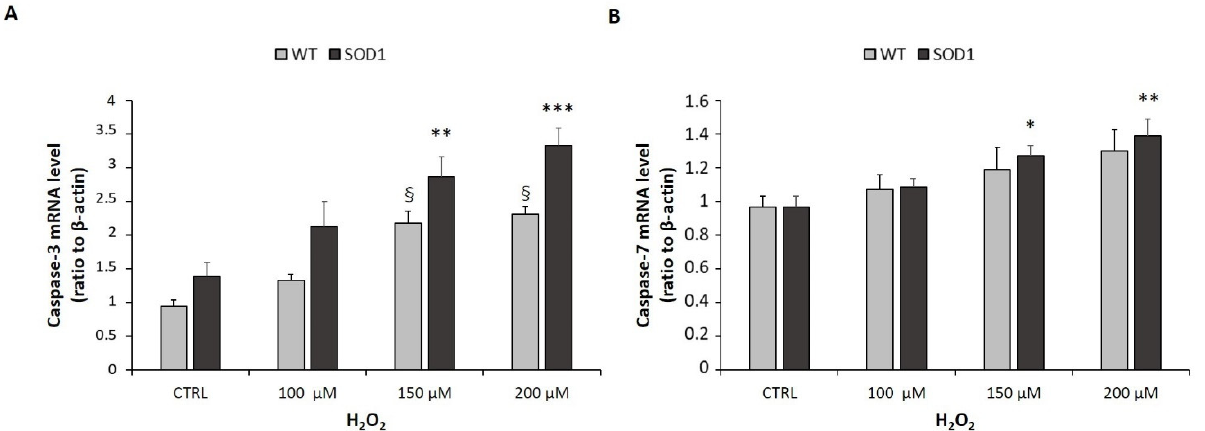
Figure 7. Caspase-3 and caspase-7 mRNA levels following incubation with increasing concentrations of H 2 O 2 . SH-SY5Y WT and SOD1 G93A cells were incubated with different concentrations of H 2 O 2 alone (0, 100, 150, 200 µM). Caspase-3 ( A ) and caspase-7 ( B ) mRNA levels were measured by RT-PCR and normalized for the respective β -actin mRNA levels. Data are expressed as mean ± SEM of 18 replicates obtained in 3 independent experiments (n = 6 in each 18 replicates obtained in 3 independent experiments ( n = 6 in each experiment). For SH-SY5Y WT: experiment). For SH-SY5Y WT: § p < 0.05 vs. CTRL; for SH-SY5Y SOD1 G93A * p < 0.05, ** p < 0.01, and § p < 0.05 vs. CTRL; for SH-SY5Y SOD1 G93A * p < 0.05, ** p < 0.01, and *** p < 0.001 vs. *** p < 0.001 vs. CTRL.